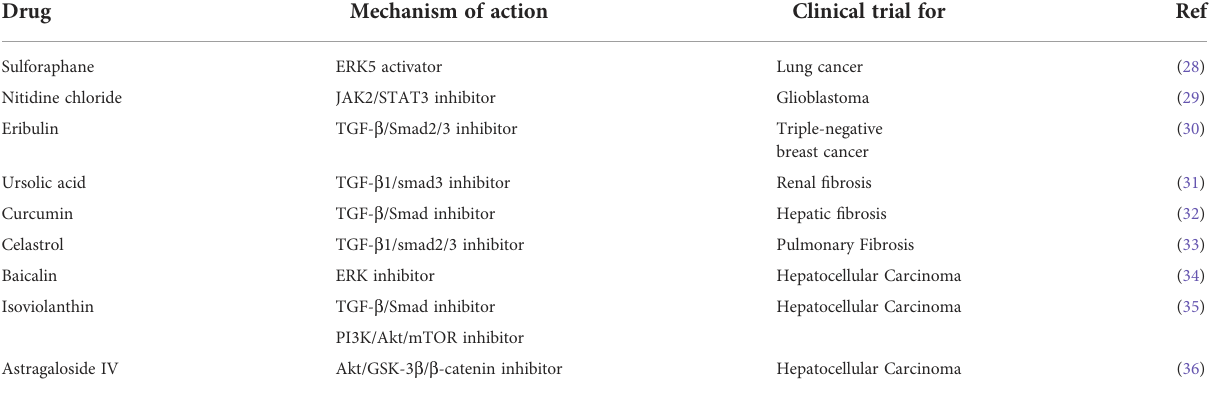
TABLE 2 Classes of natural drugs targeting epithelial-mesenchymal transition.